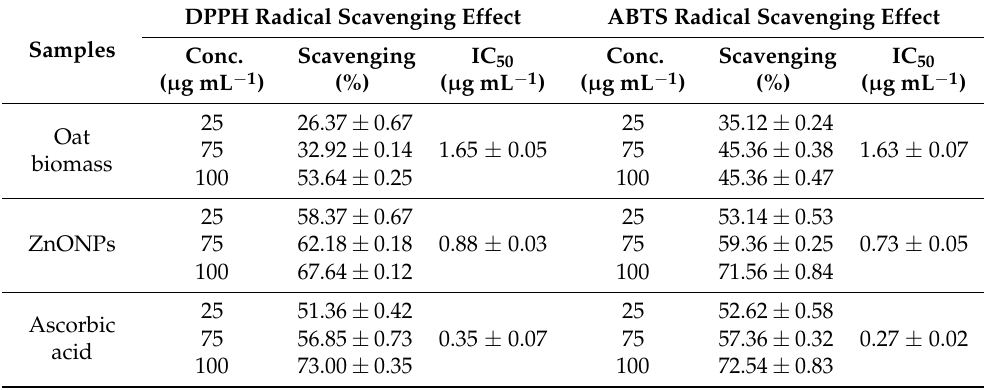
Table 4. Data obtained from DPPH and ABTS scavenging activity of oat biomass and ZnONPs in comparison with ascorbic acid as